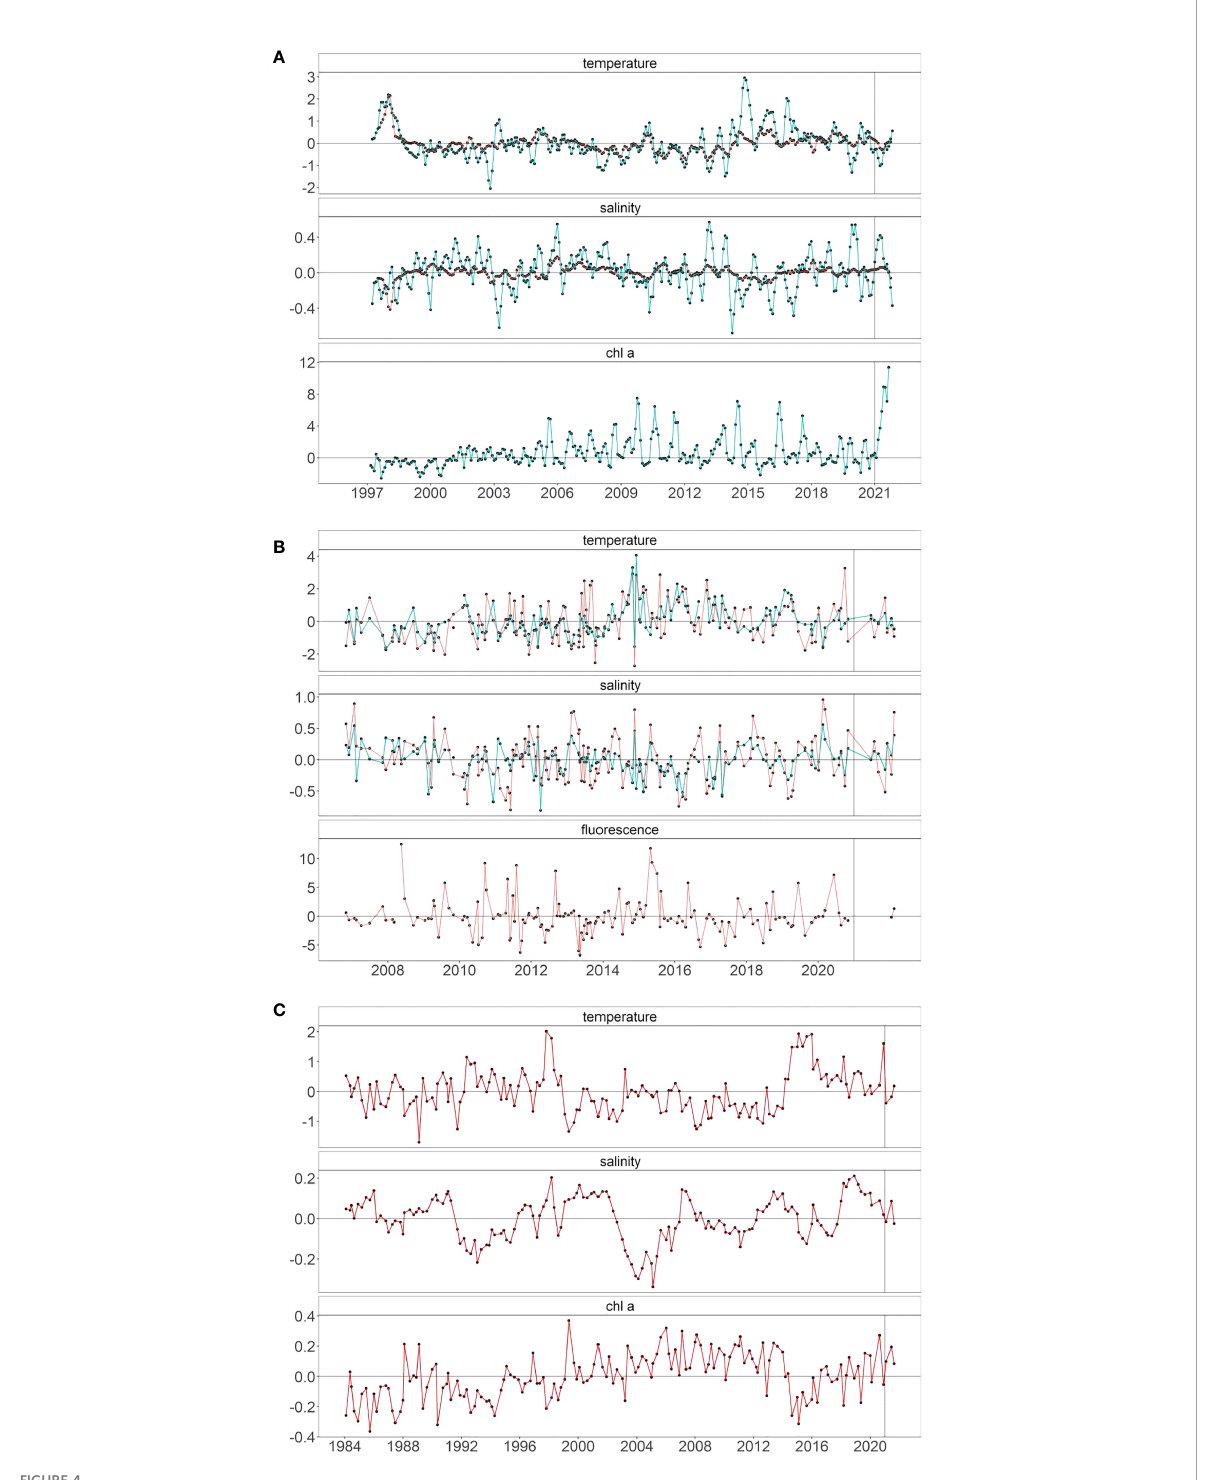
FIGURE 4 Seasonally adjusted temperature, salinity, and chlorophyll a anomalies at (A) Newport Hydrographic stations NHL5 (50 m, blue line) and NHL25 (150 m, red line), (B) Trinidad Head Line station 2 at 15 m (blue line) and 65 m (red line) with chlorophyll values integrated from 2 to 30 m, and (C) within the mixed layer averaged across the 66 core CalCOFI